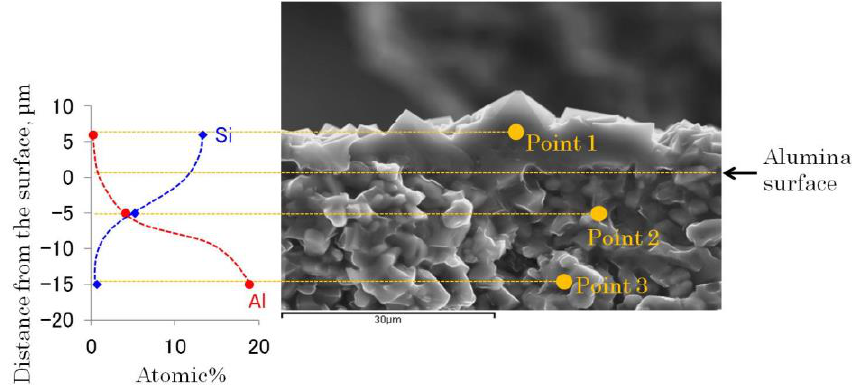
Figure 10. Si and Al composition along the ITQ-29 material grown on the alumina support.